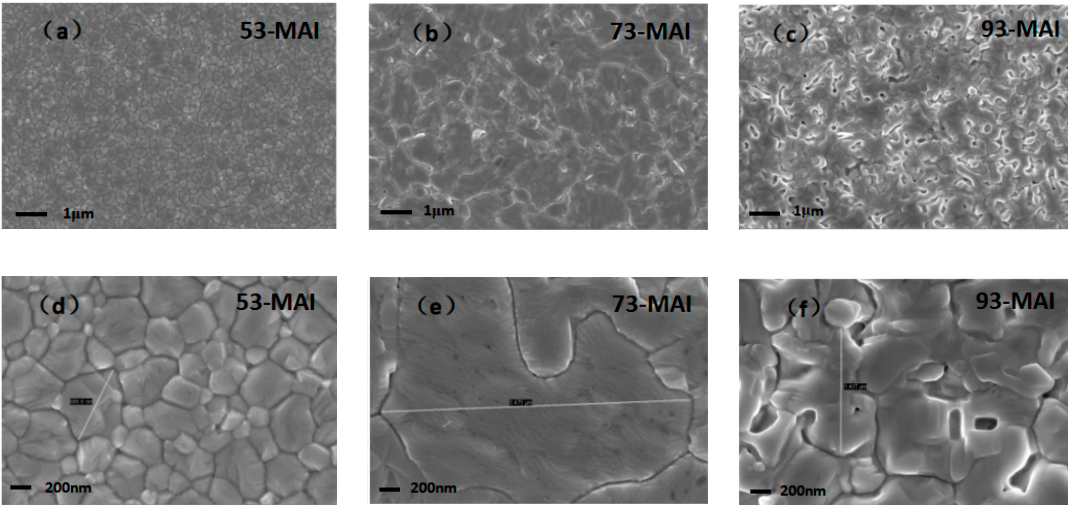
Figure 4. SEM top views of organic–inorganic hybrid perovskite films with different concentrations CH 3 NH 3 I (MAI). The concentrations of ( a – c ) are 53 mg / mL, 73 mg / mL, and 93 mg / mL, respectively; of CH 3 NH 3 I (MAI). The concentrations of ( a – c ) are 53 mg/mL, 73 mg/mL, and 93 mg/mL, respectively; ( d – f ) are enlarged views of ( a – c ( d – f ) are enlarged views of ( a – c ).